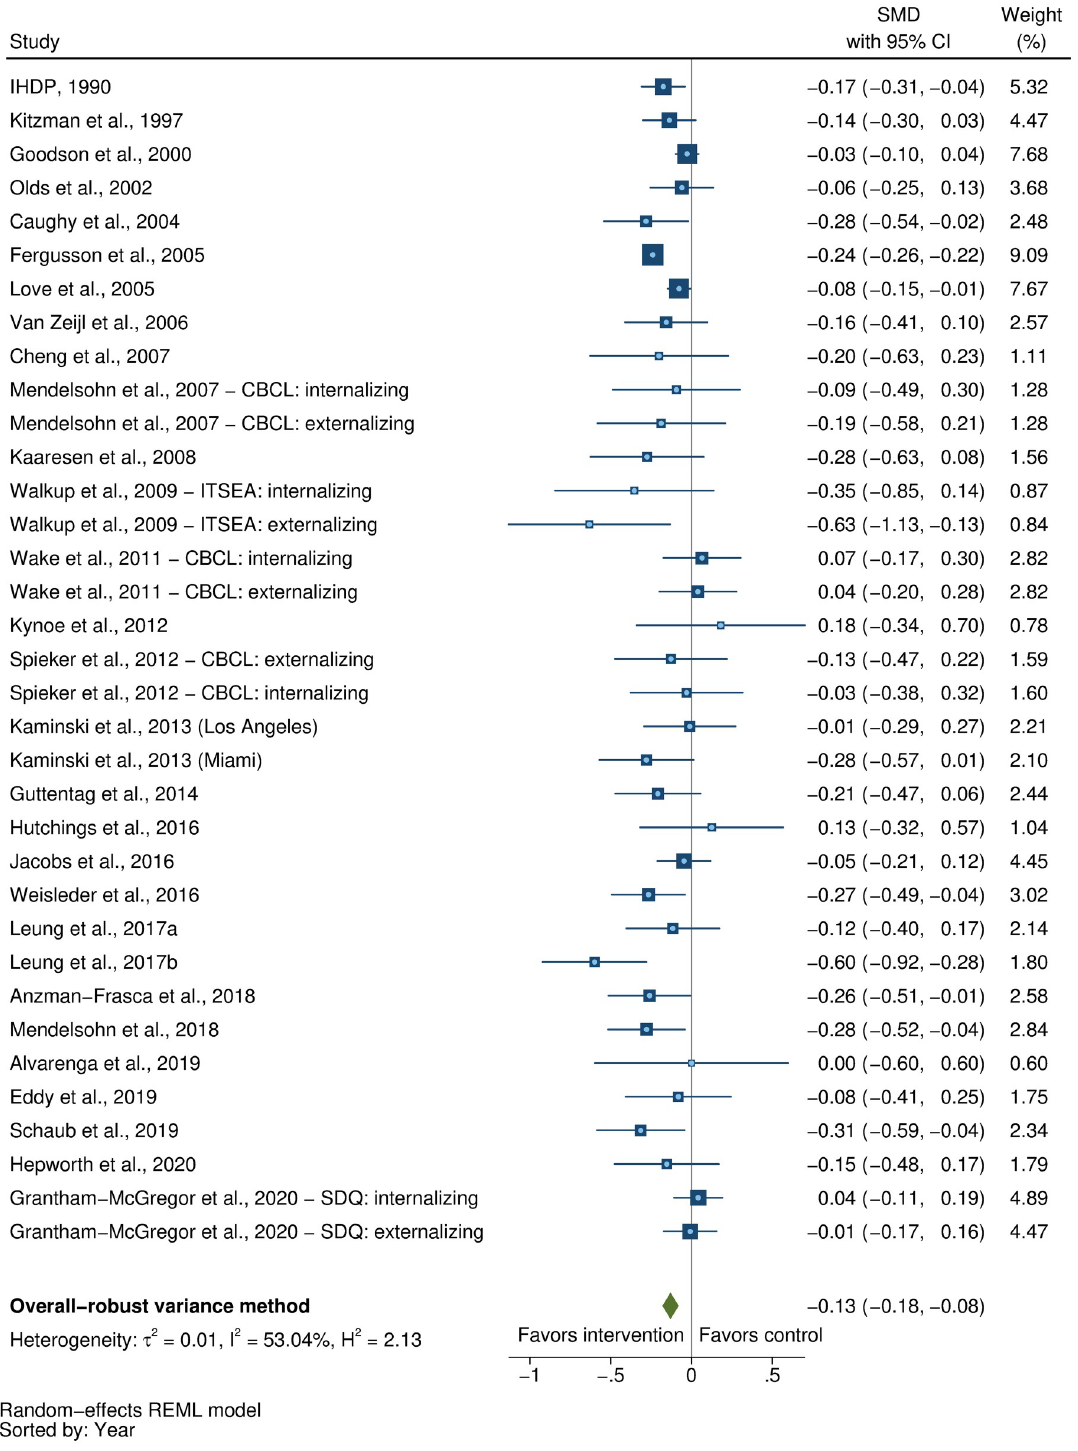
PLOS Medicine| https://doi.org/10.1371/journal.pmed.1003602 May 10, 2021 29 /